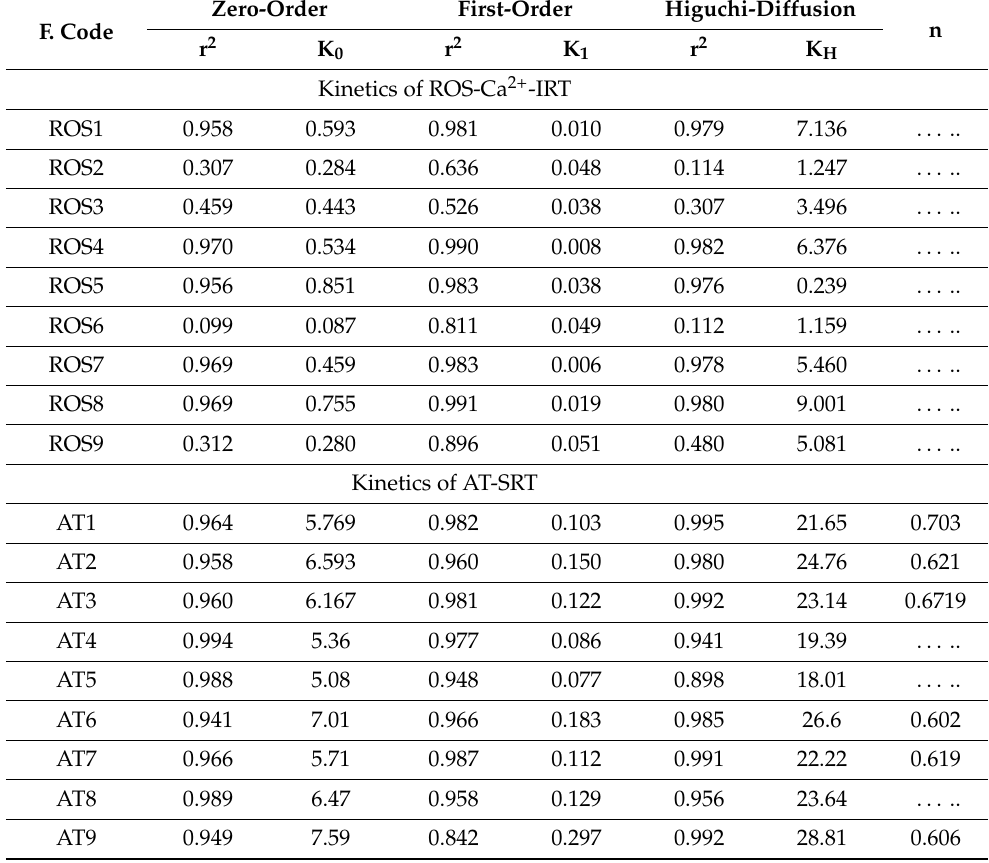
Table 9. Kinetic analysis of the prepared IRT/SRT formulations. F.